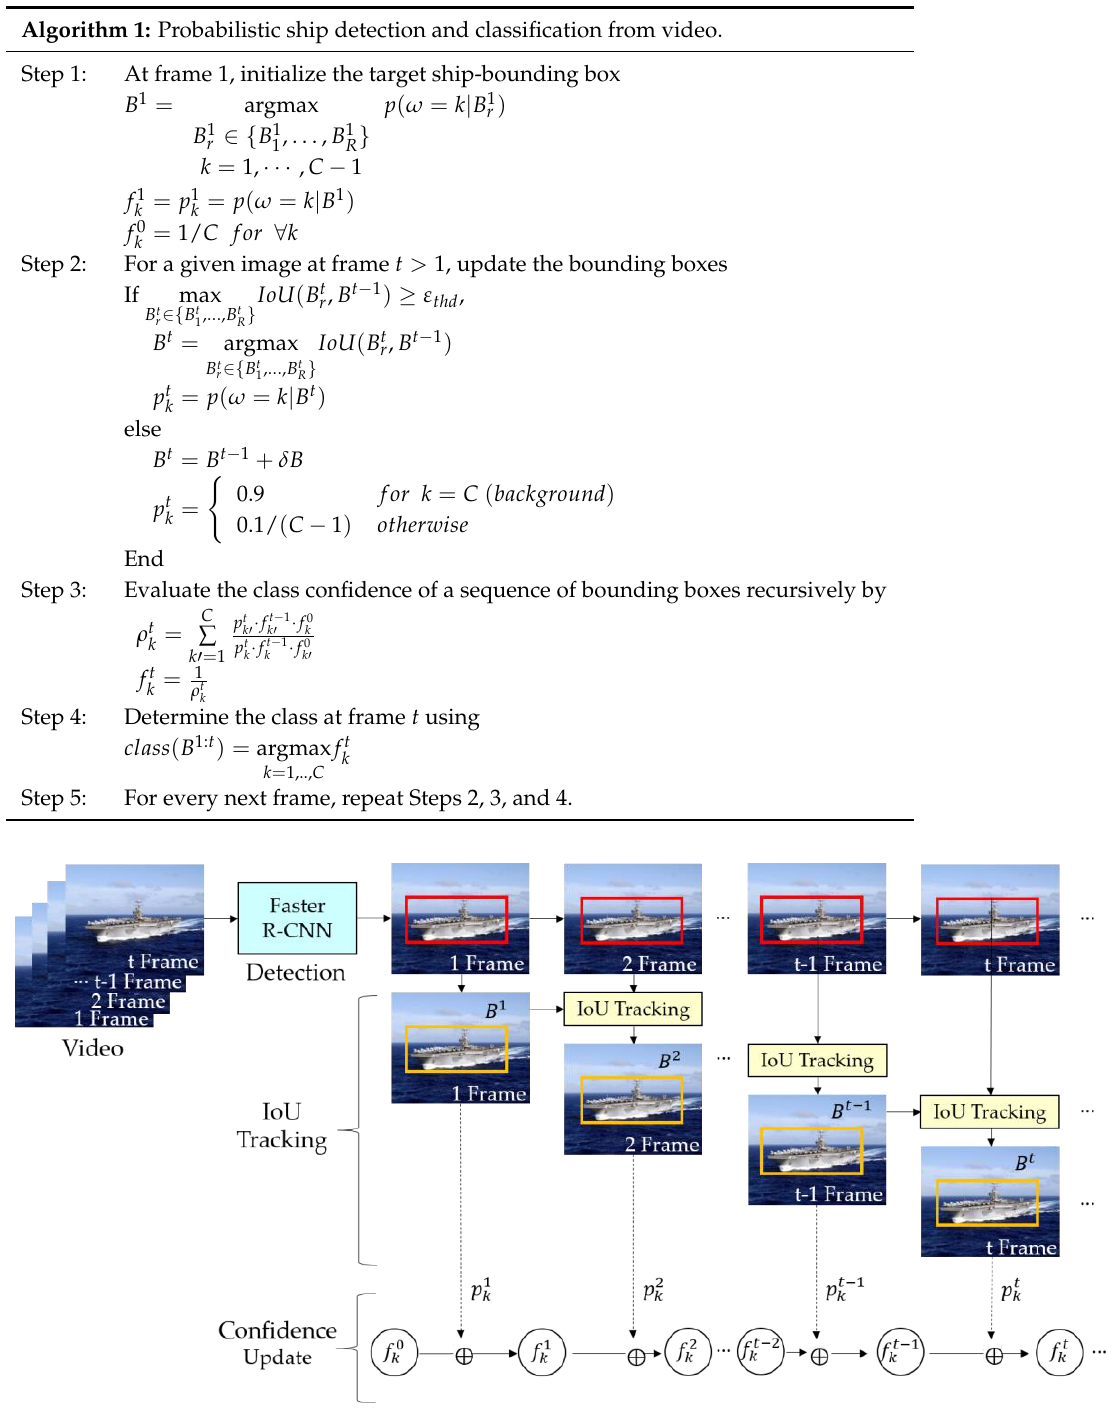
Algorithm 1: Probabilistic ship detection and classification from video.